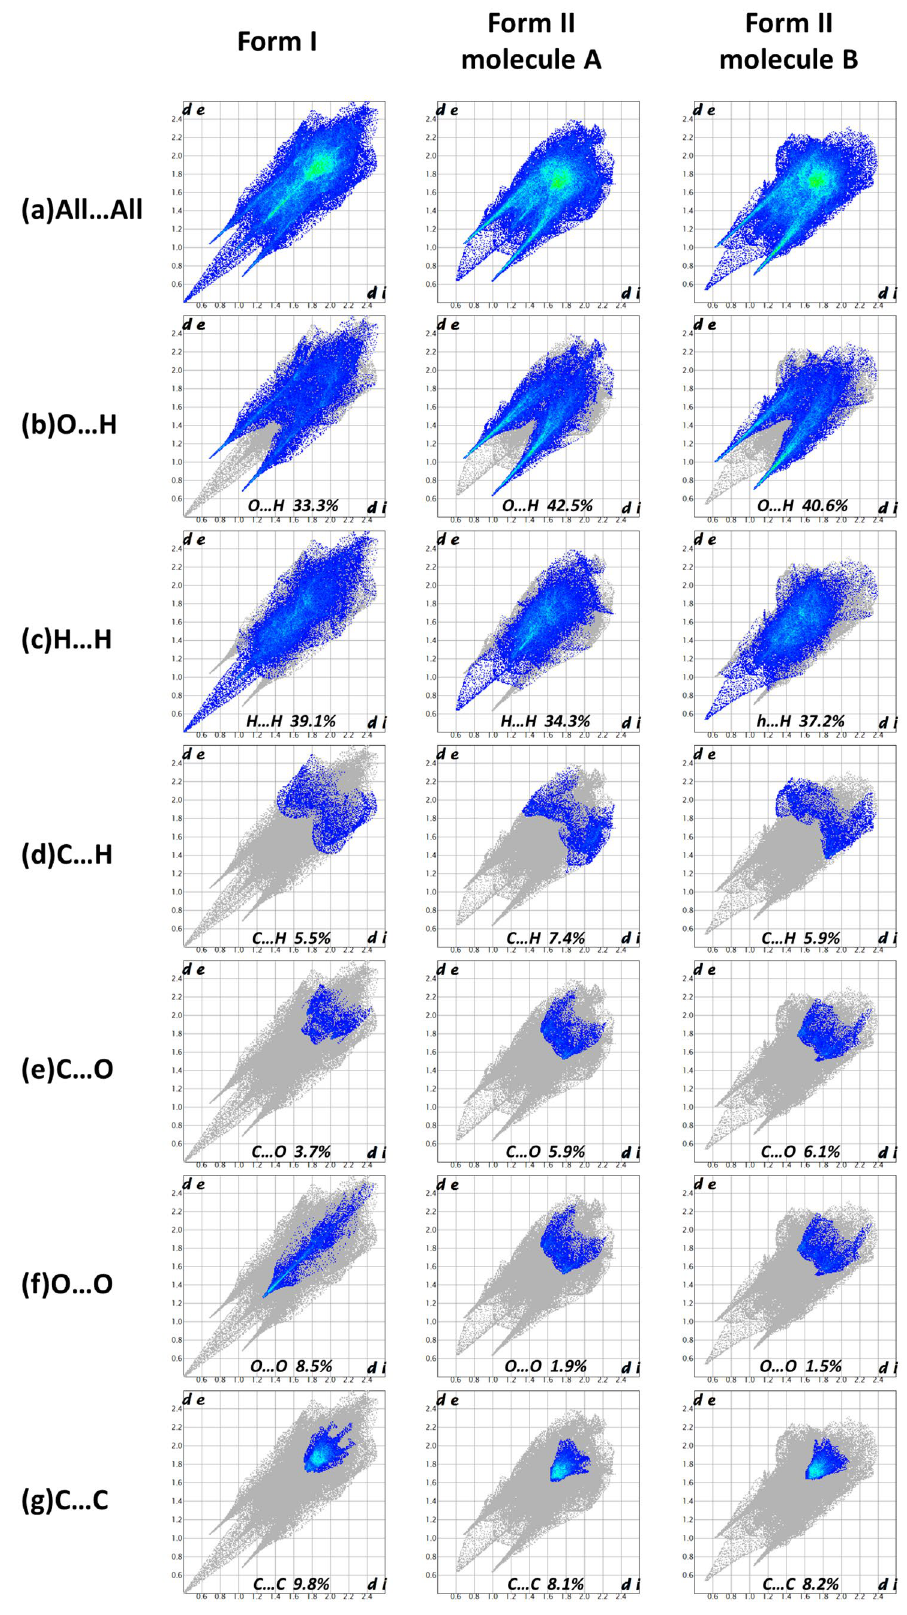
Fig. 7 Fingerprint plots of intermolecular interactions of mangiferin form I and form